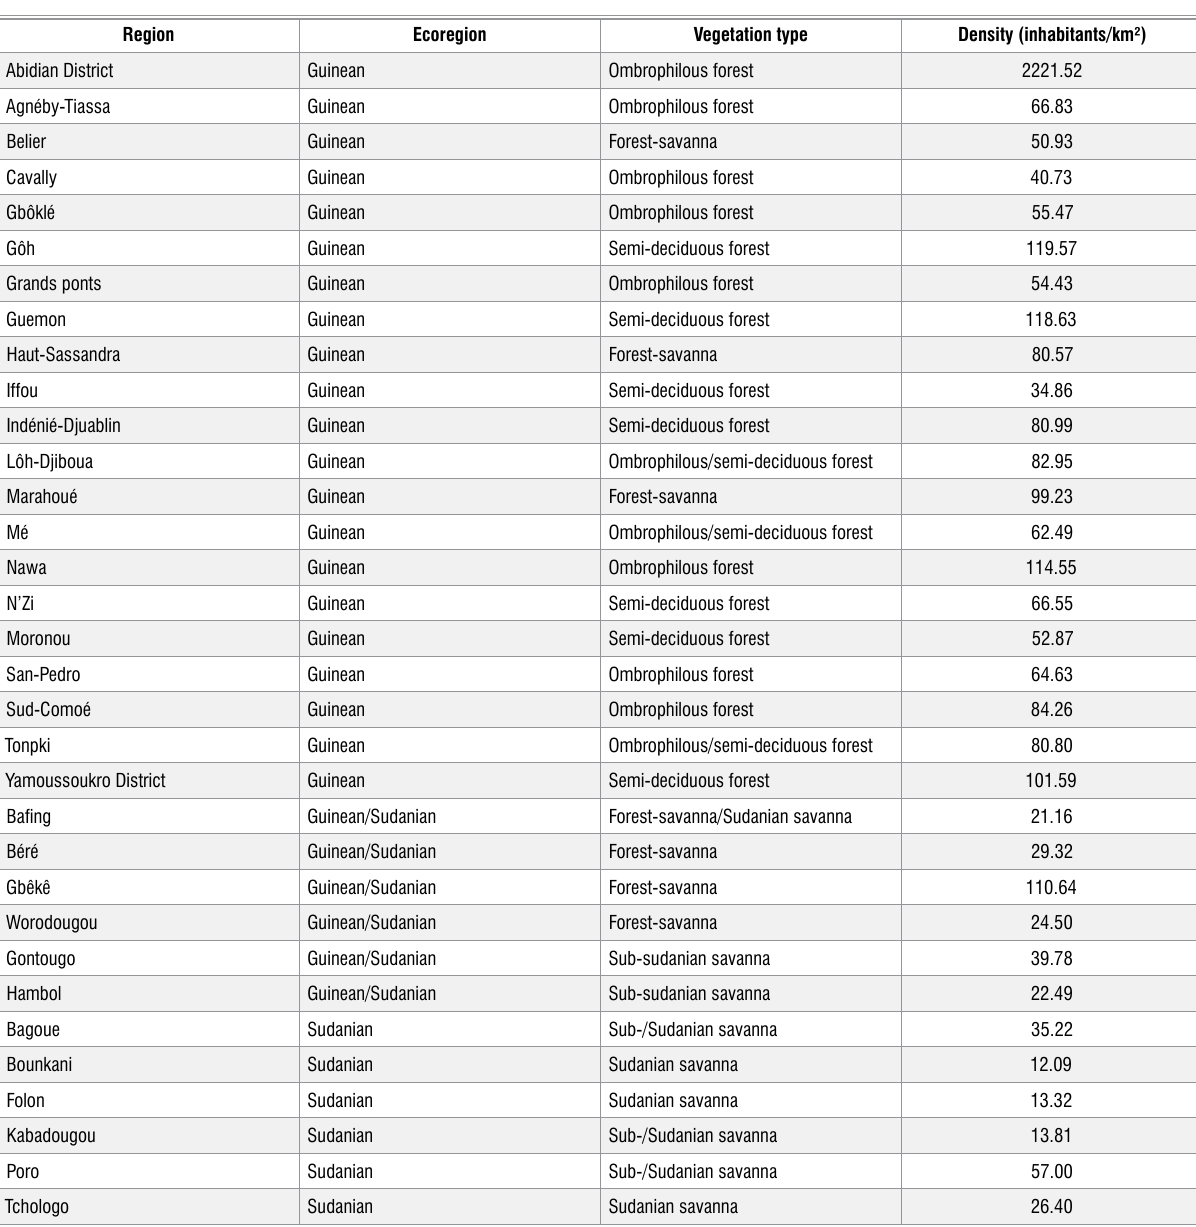
Table 1: Human population densities by region of Côte d’Ivoire. 15